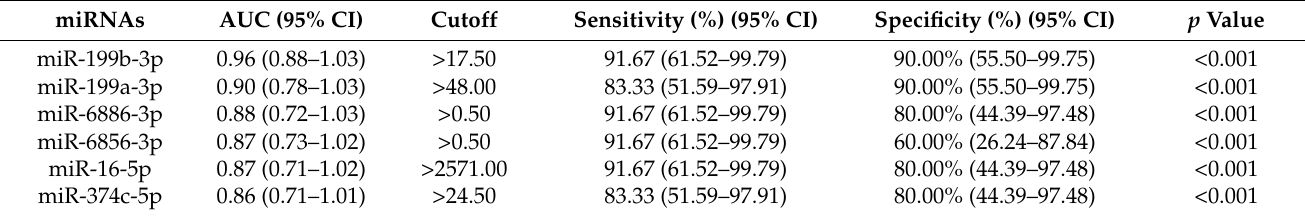
Table 2. The diagnostic utility of differently expressed miRNAs for